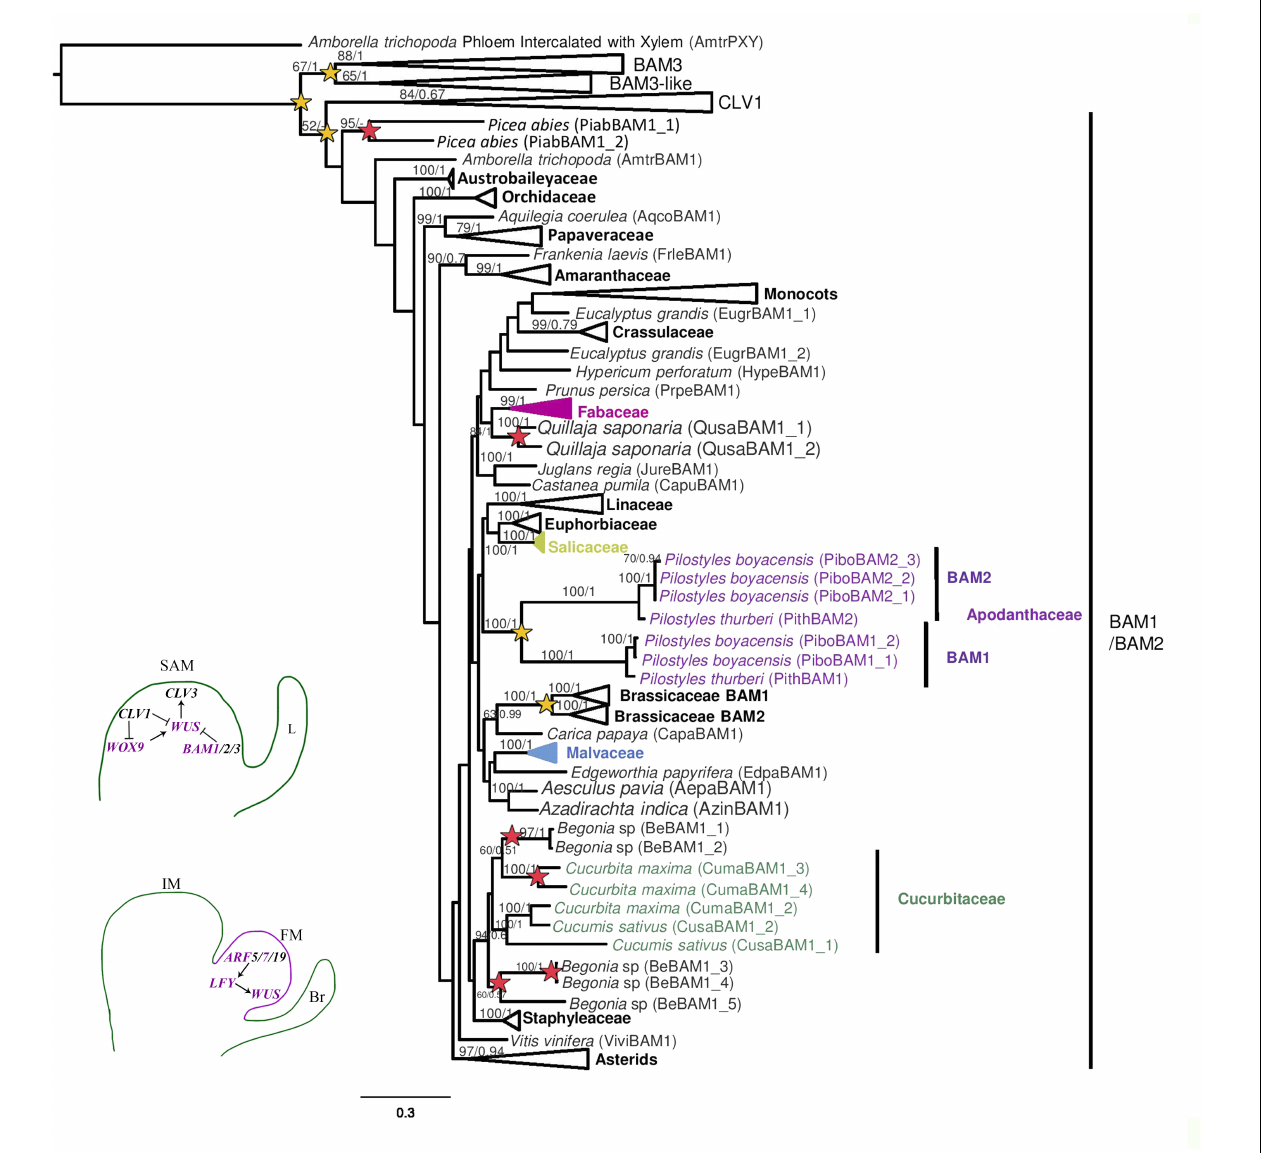
FIGURE 5 | Maximum likelihood reconstruction of BARELY ANY MERISTEM 1-3 and CLAVATA1 gene lineages. Superclades without sequences from Pilostyles boyacensis are collapsed. Bootstrap values > 50 and posterior probability are shown above the nodes. Yellow stars indicate large scale or family-level duplication events; red stars indicate species-specific duplication events. Schemes in the bottom left follow the conventions in Figure 2